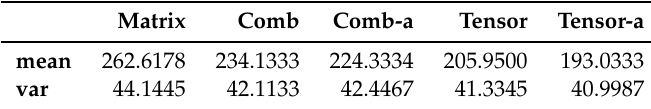
Table 10. Iterations for each method (Source: Authors).